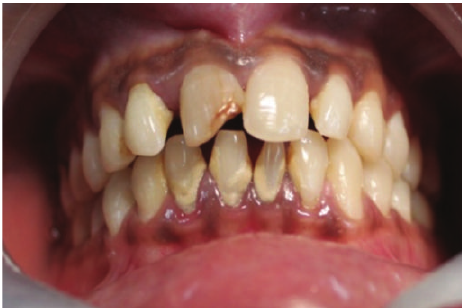
Figure 27: Pre-operative photo showing fractured and discolored 11 and displaced 12.